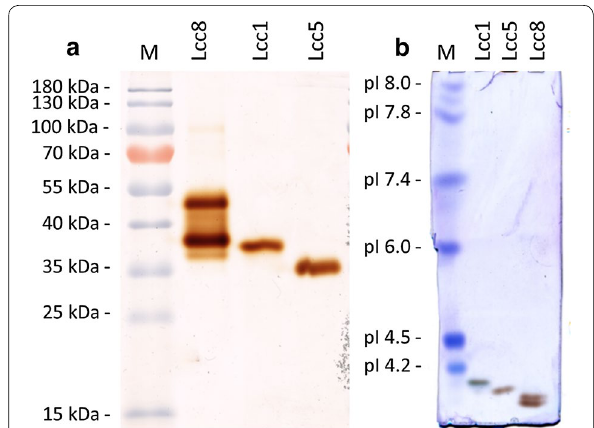
Fig. 3 a Zymogram of purified Lcc8, Lcc1 and Lcc5 (all 20 mU) and stained with laccase substrates 10 mM MBTH and 10 mM DHPPA. b Isoelectric focusing PAGE stained with laccase substrate MBTH/ DHPPA. The figure shows the samples M SERVA IEF Marker 3–10 = Liquid Mix, purified Lcc1, Lcc5 and